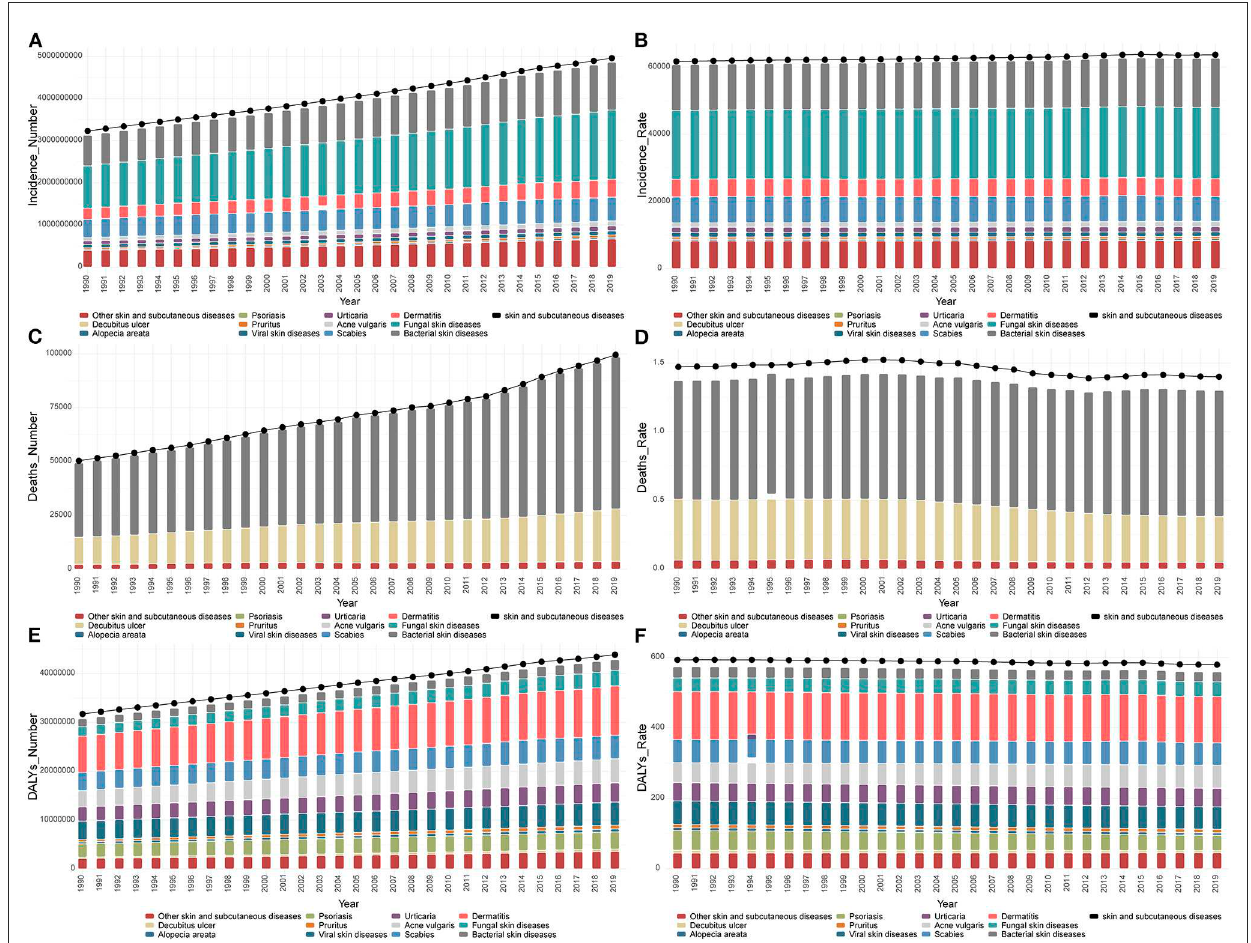
FIGURE1 General status of global skin and subcutaneous diseases burden. (A) New cases of each skin and subcutaneous disease globally from 1990 to 2019. (B) ASIR of each skin and subcutaneous disease globally from 1990 to 2019. (C) Deaths from each skin and subcutaneous disease globally from 1990 to 2019. (D) ASDR from each skin and subcutaneous disease globally from 1990 to 2019. (E) DALYs from each skin and subcutaneous disease globally from 1990 to 2019. (F) ASDAR from each skin and subcutaneous disease globally from 1990 to 2019. ASIR, age-standardized incidence rate; DALYs, disability-adjusted life years; ASDAR, age-standardized DALYs rate; ASDR, age-standardized death